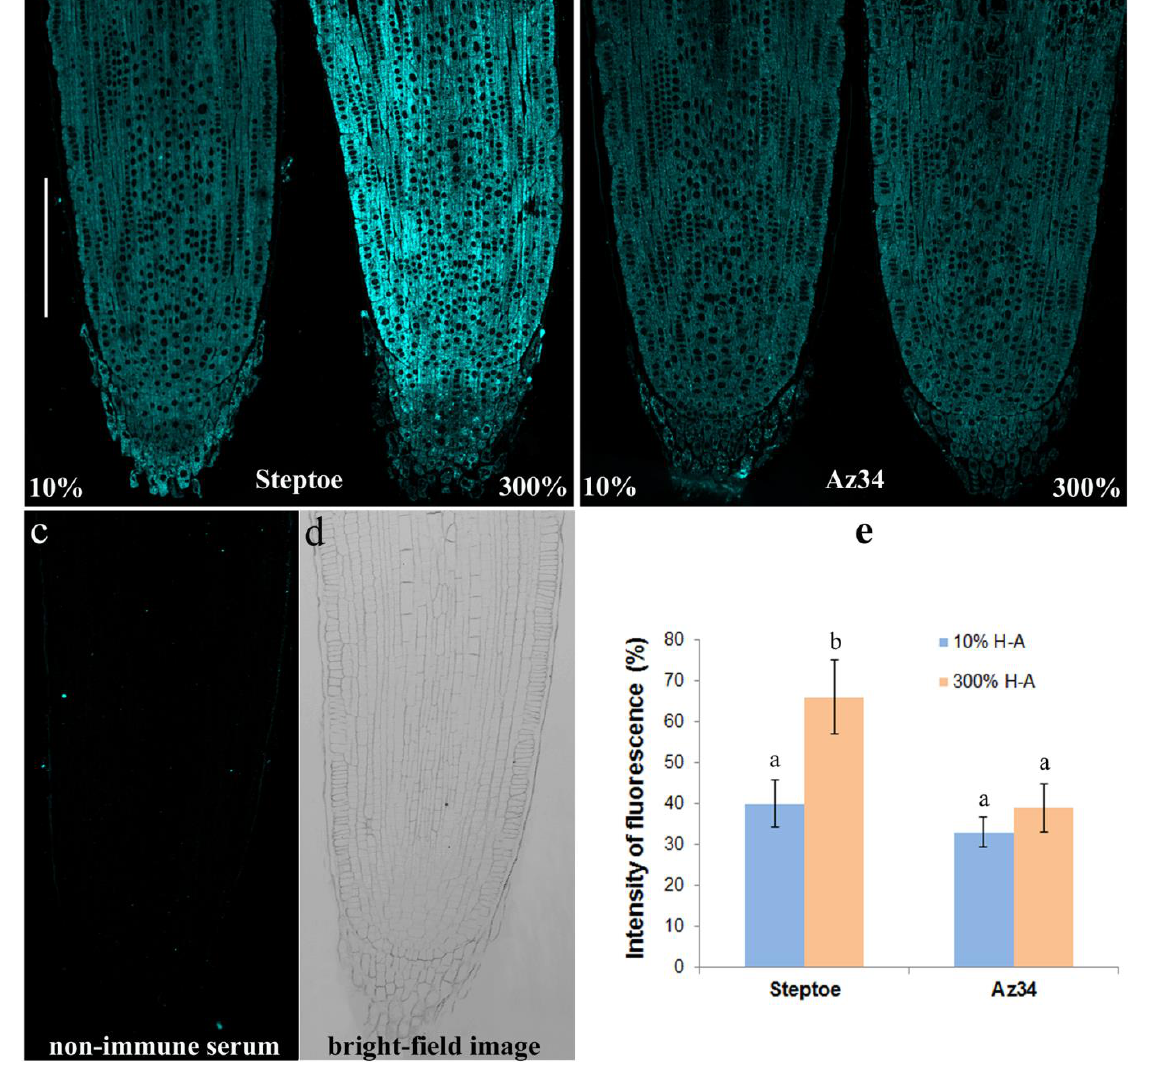
Figure 7. Cytokinin localization in the root tips of Steptoe ( a ) and Az34 ( b ) 6-day-old plants grown on either 300% or 10% of H-A solution. Immunohistochemical control with non-immune serum ( c ) and the bright-light image of the root tips ( d ). Fluorescence for cytokinins (means ± SE, arbitrary units, maximal fluorescence taken as 100%, minimal as 0%) ( e ). Statistically different means (n = 9) are indicated by different letters ( p < 0.05, ANOVA, Duncan’s test). Scale bar is 200 µM.